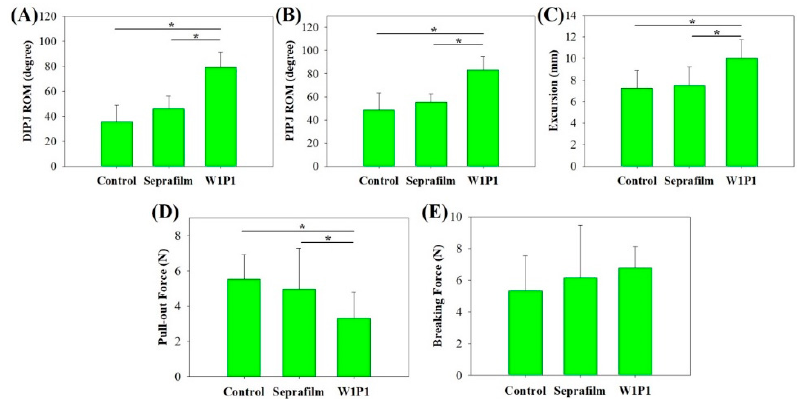
Figure 8. The quantitative evaluations of the antiadhesion efficacy in different groups in vivo: The range of motion (ROM) of the ( A ) distal interphalangeal (DIP) and ( B ) proximal interphalangeal (PIP) joints. The W1P1 group had a significantly greater ROM than the control and Seprafilm groups. ( C ) Tendon excursion, which is the distance that the repaired tendon could glide out of the adhesion, was significantly greater in the W1P1 group than the other two groups. ( D ) The pullout force, which is the force required to completely drag the FDP tendon out of the tendon sheath and its surrounding adhesion, was positively correlated with adhesion severity. Tendons treated with the W1P1 NFM required the least force and significantly less force than the other tendons. ( E ) The breaking force, which is the force required to tear the tendon apart by pulling its ends, was correlated with the degree of healing of the tendon. A greater breaking strength was noted in the W1P1 group than the other groups, but the differences were nonsignificant. * p <